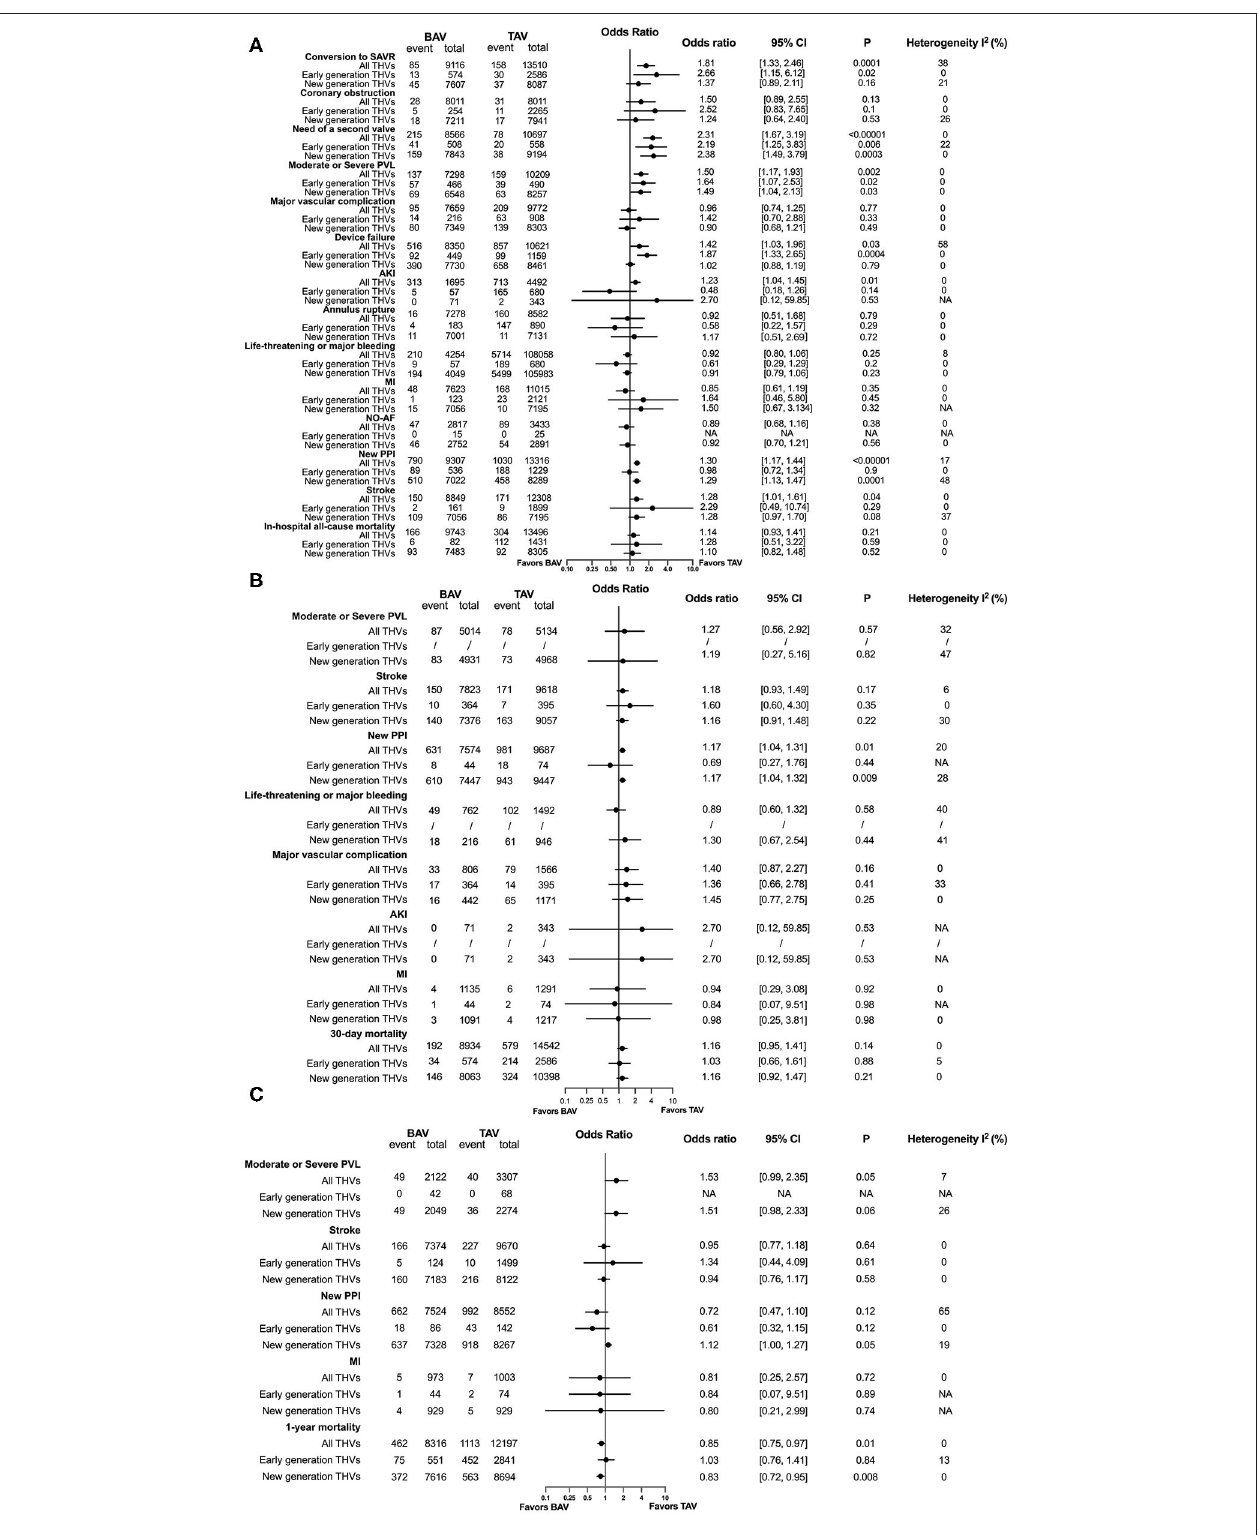
FIGURE 3 | Procedural complications and outcomes between BAV and tricuspid aortic valve (TAV) at in-hospital time (A) , in a 30-day (B) , and in a 1-year (C) follow-up. SAVR, surgical aortic valve replacement; PVL, paravalvular leakage; AKI, acute kidney injury; MI, myocardial infarction; NO-AF, new-onset atrial fibrillation; PPI, permanent pacemaker